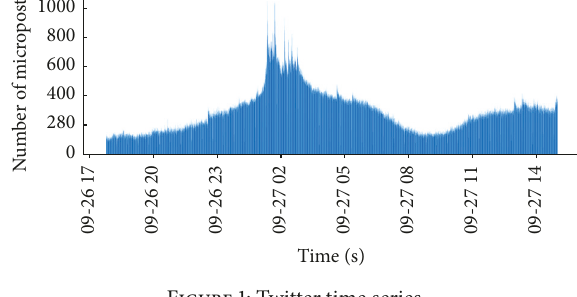
Figure 1: Twitter time series.